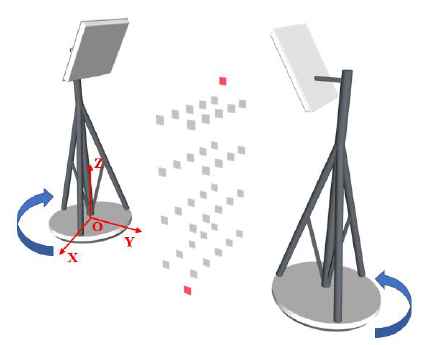
Figure 6. Three-dimensional (3D) deployment.